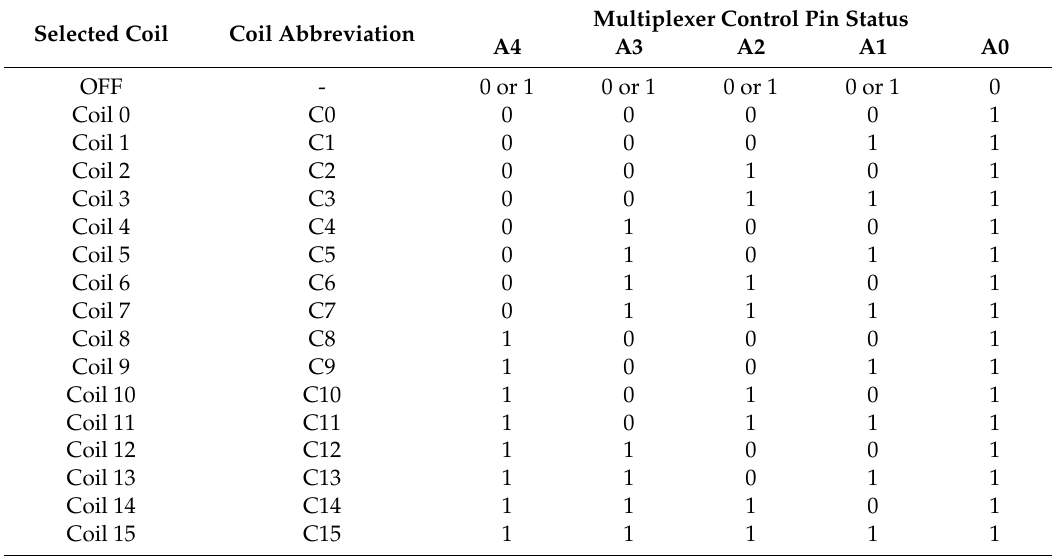
Table 2. Truth table of the multiplexer channels for coils activation: (0) deactivated; (1) activated. Selected Coil Coil